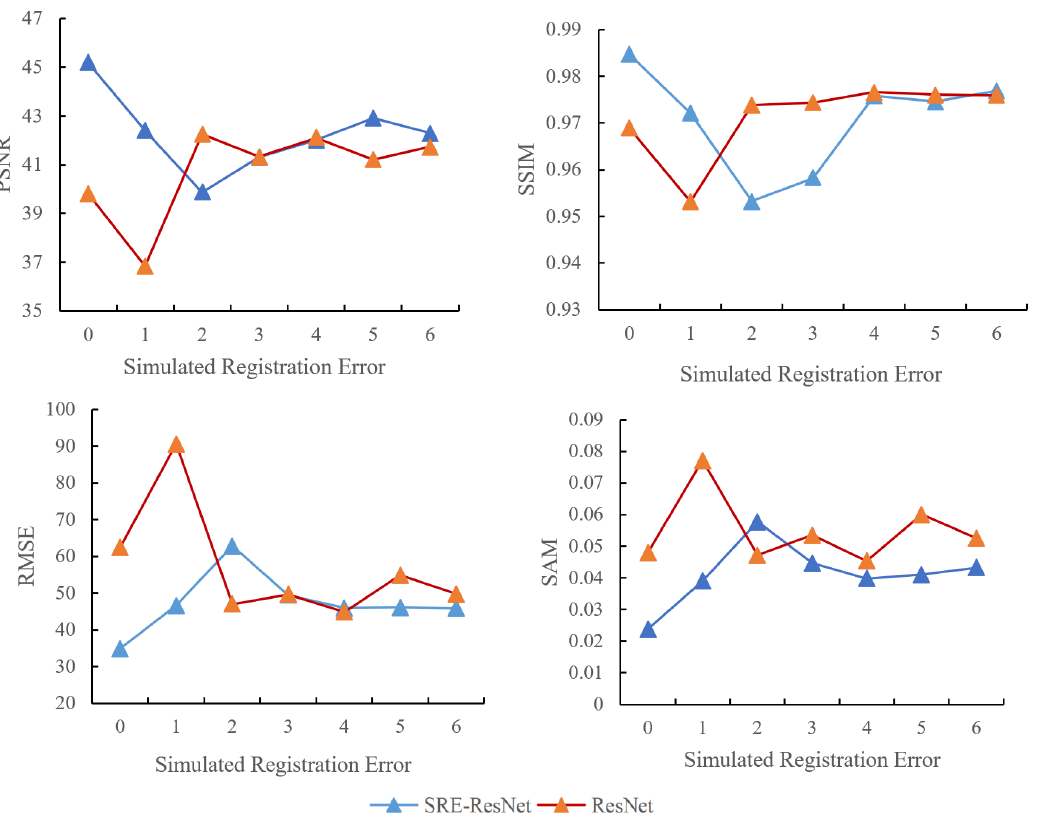
11 of 19 Figure 8. Simulation of registration errors between hyperspectral data and multispectral data. Seven experiments were conducted between SRE-ResNet and ResNet for the two da- tasets. There are 21 experiment results overall. Figures 9 and 10 show the different indices results for the two datasets. They are PSNR, SSIM, RMSE and SAM. For Dataset I, SRE- ResNet and ResNet both perform well when it comes to different simulated registration errors. This proves that SRE-ResNet can restore original data without decreasing too much original spatial and spectral information. For Dataset II, SRE-ResNet outperforms ResNet